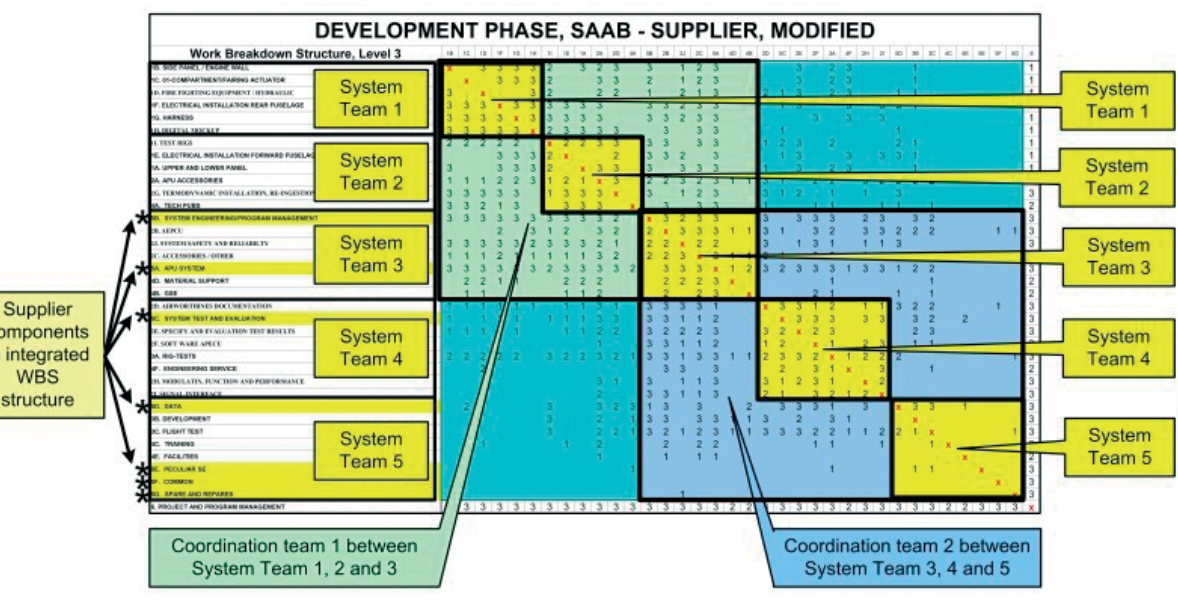
Figure 6: DSM-Analysis on WBS-Level 3, suggested integrated system team